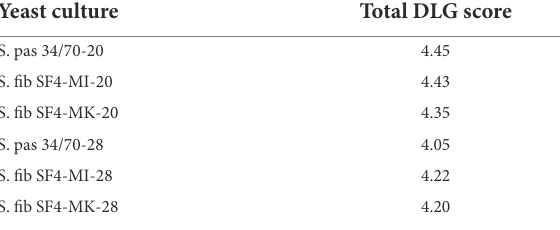
TABLE 6 Total DLG score according to the DLG evaluation scheme excluding the quality of bitterness as well as carbonation of the investigated beers fermented with S. fibuligera S. fib SF4 yeast cultures and reference yeast strain S. pastorianus S. pas 34/70 at 20 ° C and 28 ° C.